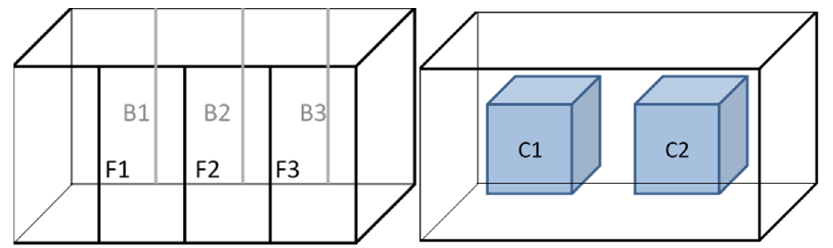
Figure 2. Sampling collection location , front (F) and back (B) of the bales divided into the three sampling sections, plus the two samples collected in each center of a half-bale (C).